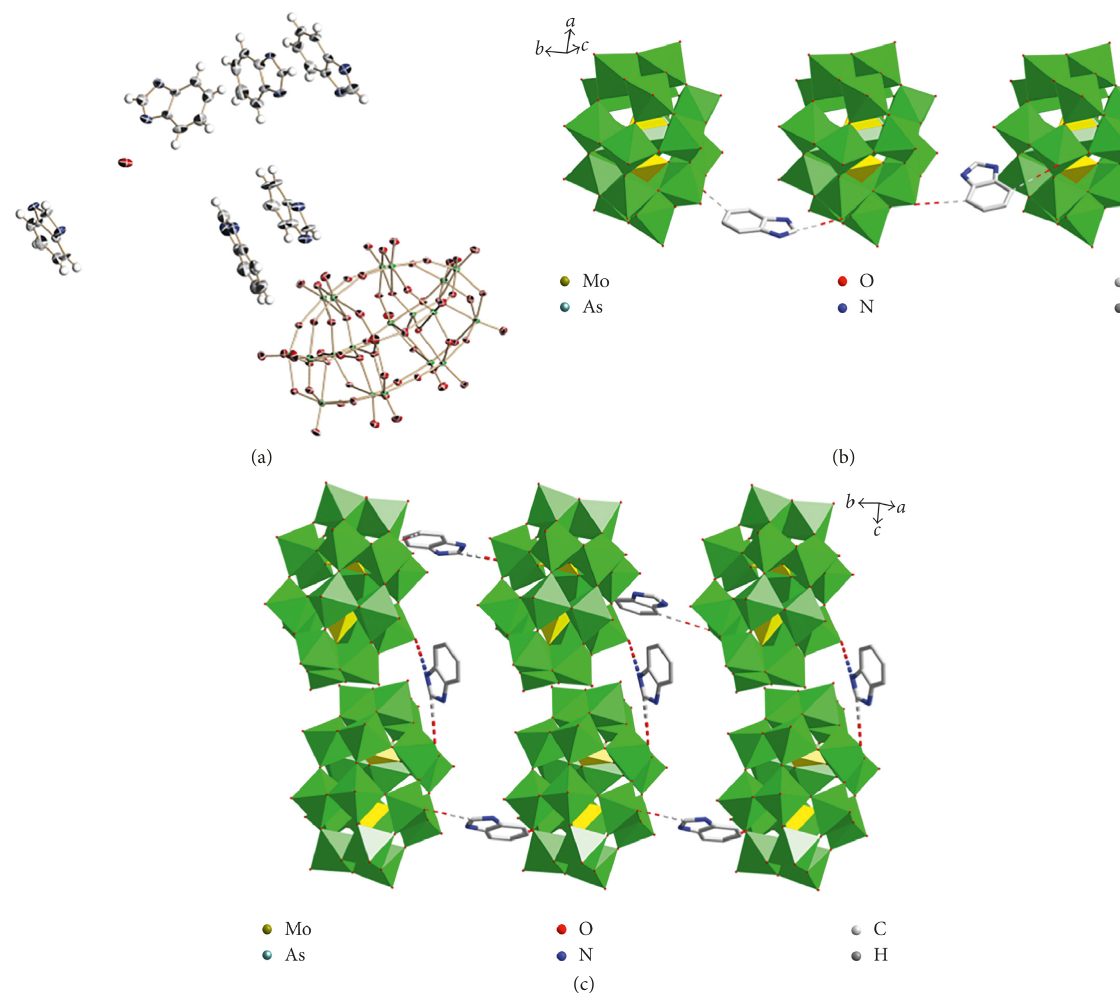
Figure 2: (a) An ORTEP drawing for the molecular unit of 1 in 50% thermal ellipsoids; (b) a drawing with polyhedral and ball-stick pattern for the one-dimensional chain in complex 1 by H-bonds; (c) a picture showing the H-bond interaction between the 2D